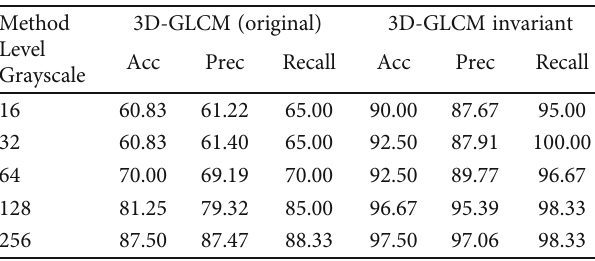
Figure 5: Pneumonia X-ray image: (a) image of pneumonia su ff erers; (b) nonpneumonia images. Table 5: Test results on the brain tumor MRI